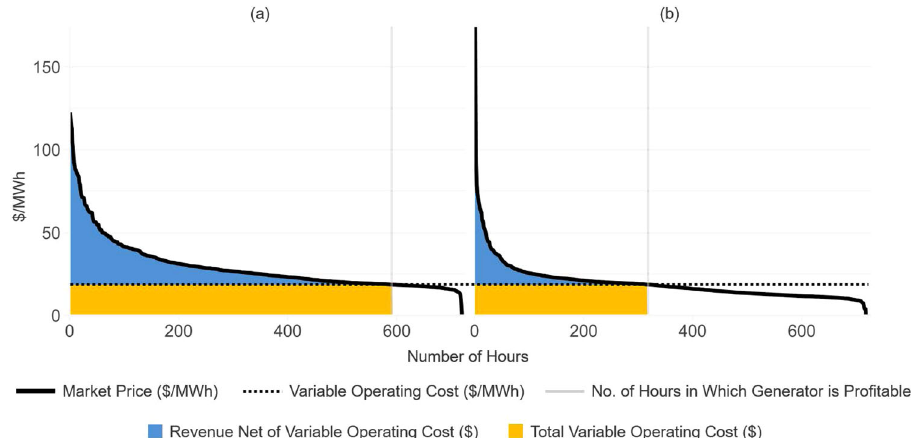
Fig. 6 Monthly price duration curve, electricity market revenues, and variable operating costs using a price forecast published prior to shelter-in-place orders, and actual prices. Electricity market pro fi ts (blue area) and total variable operating costs (yellow area) are shown for "Rockport ST1'', a coal- fi red generation unit in the American Electric Power (AEP) Zone in the Pennsylvania − New Jersey − Maryland (PJM) interconnection electricity market, in the month of June 2020, using a price forecast published prior to shelter-in-place orders (panel a) and actual prices (panel